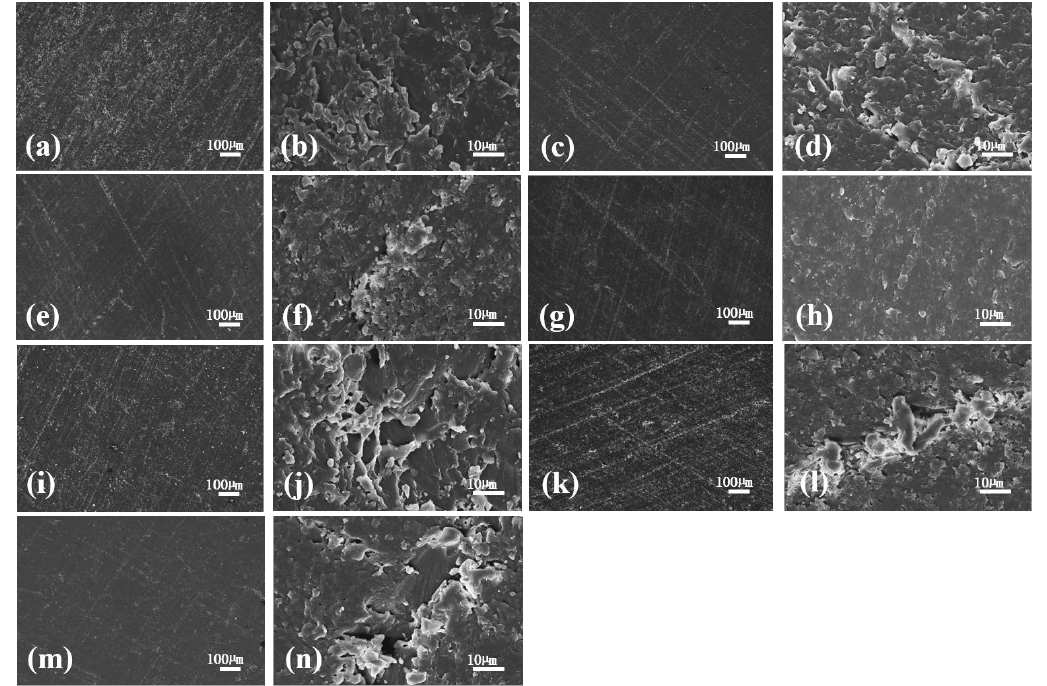
Figure 5. SEM images of abraded coating surfaces of samples with different NGS content: ( a , b ) 0 wt%, ( c , d ) 0.001 wt%, ( e , f ) 0.003 wt%, ( g , h ) 0.005 wt%, ( i , j ) 0.007 wt%, ( k , l ) 0.01 wt%, ( m , n ) 0.03 wt%.